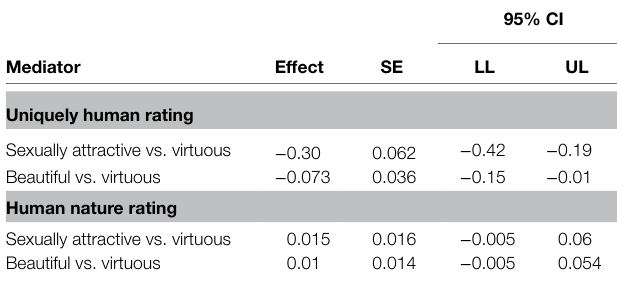
TABLE 2 | Relative indirect effects.